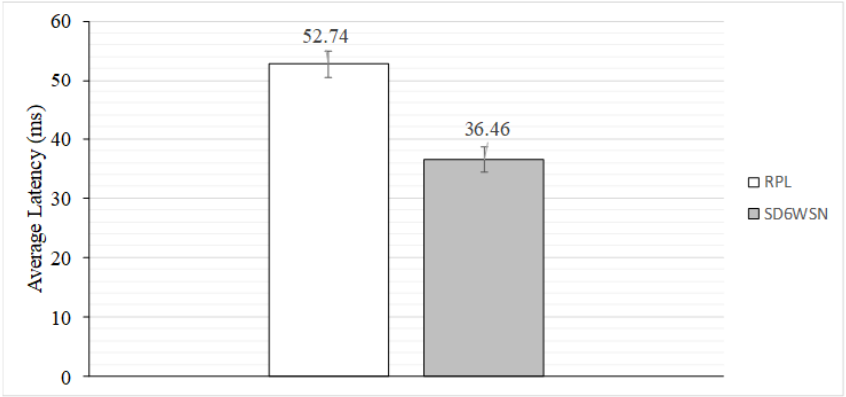
Figure 24. Average latency comparison between RPL and SD6WSN